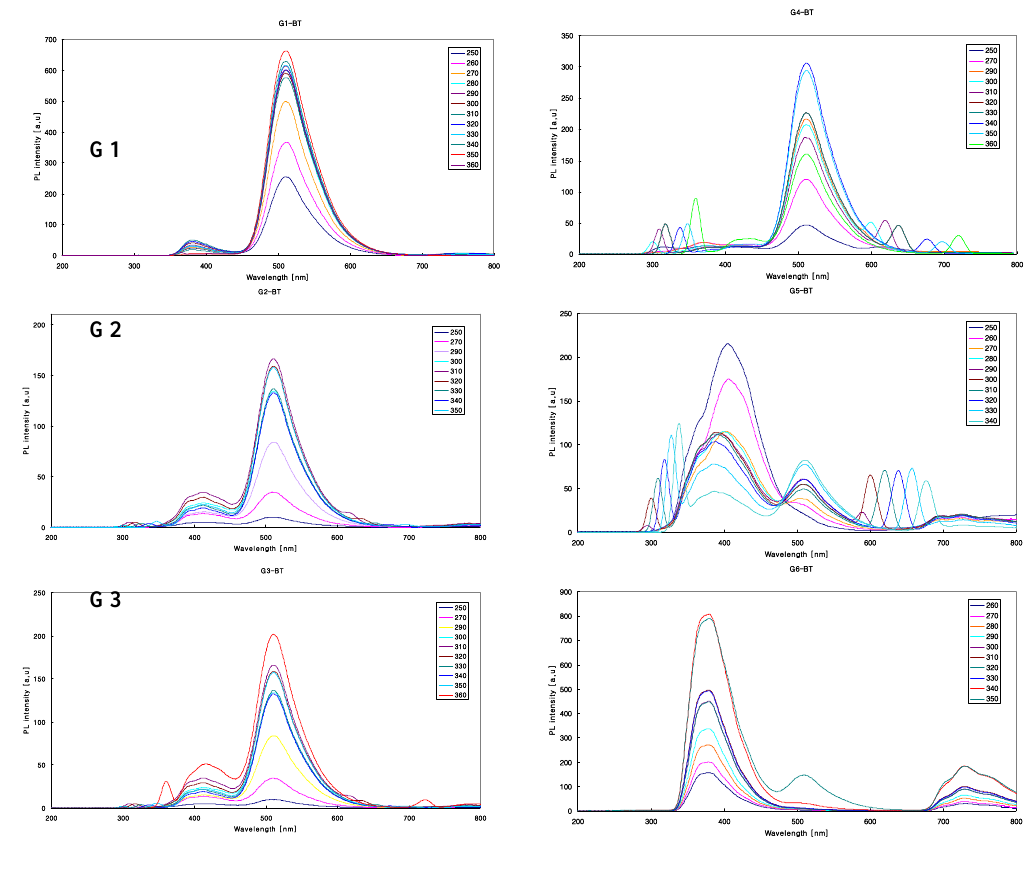
Figure 2. PL properties of benzothiazole dendrimers from 1 st to 6 th generations.